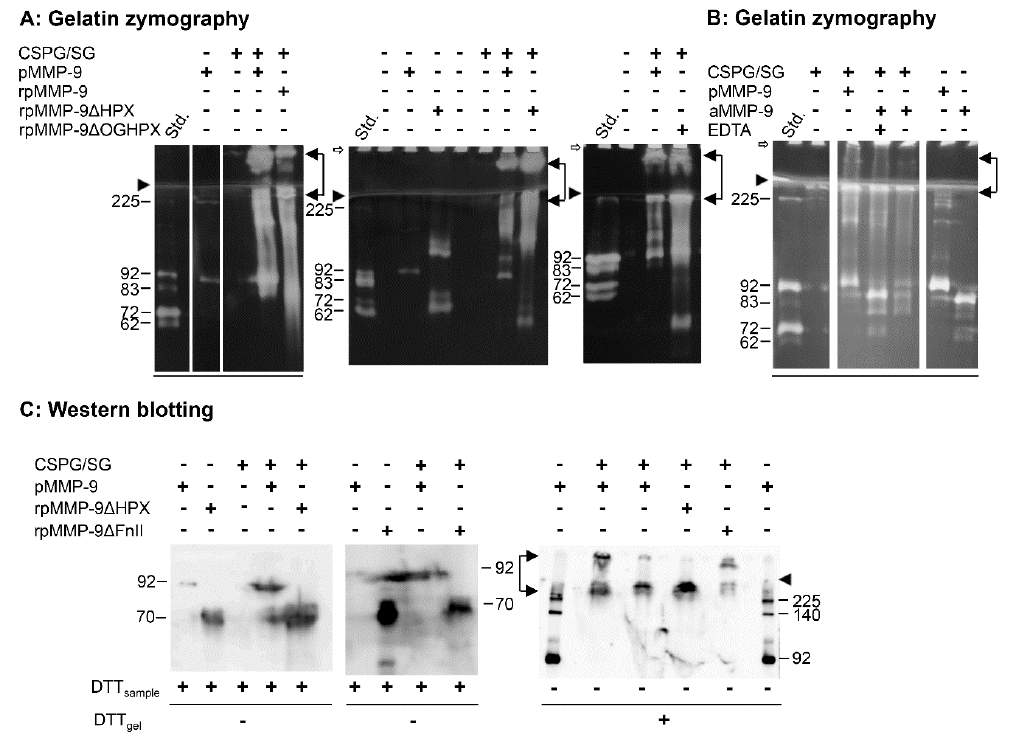
Figure 3. In vitro reconstitution of complexes between proMMP-9 and proMMP-9 deletion variants with CSPG / SG. Gelatin zymography ( A , B ) and Western blots ( C ) of proMMP-9 from THP-1 cells (pMMP-9), recombinant proMMP-9 (rpMMP-9), HPX-deleted proMMP-9 (rpMMP-9 ∆ HPX), FnII-deleted proMMP-9 (rpMMP-9 ∆ FnII), and trypsin-activated proMMP-9 from THP-1 cells